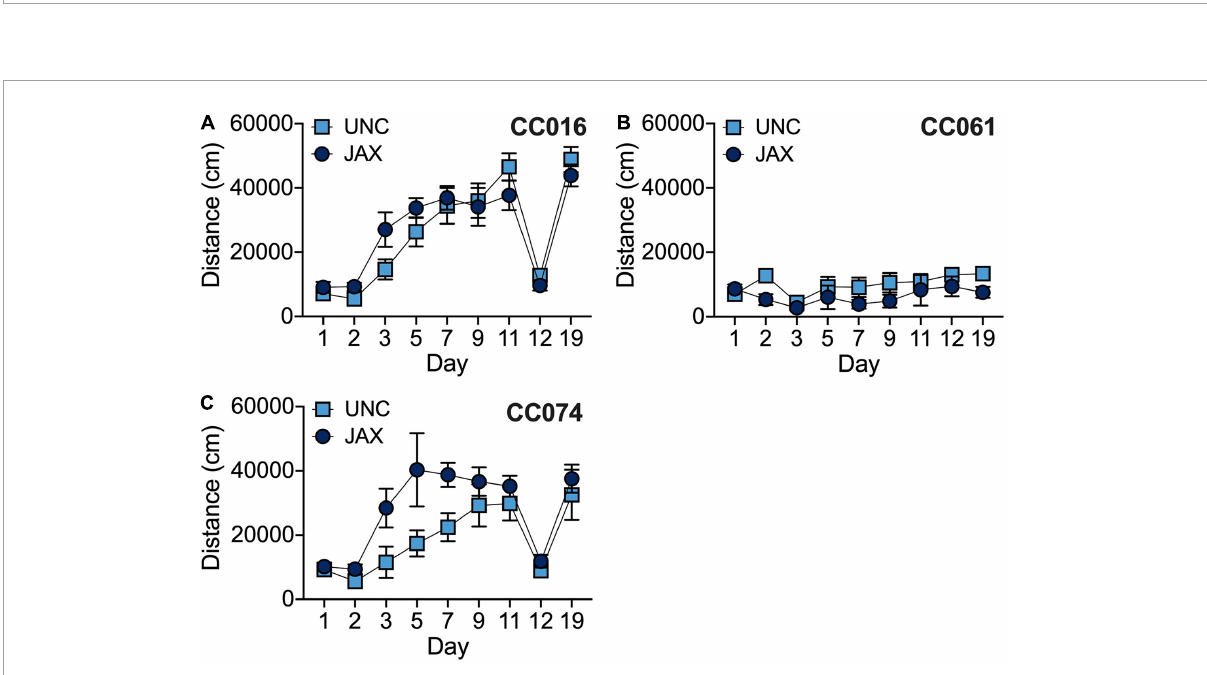
FIGURE6 Comparison of behavioral sensitization in CC016/GeniUncJ (A) , CC061/GeniUncJ (B) and CC074/UncJ (C) strains across test